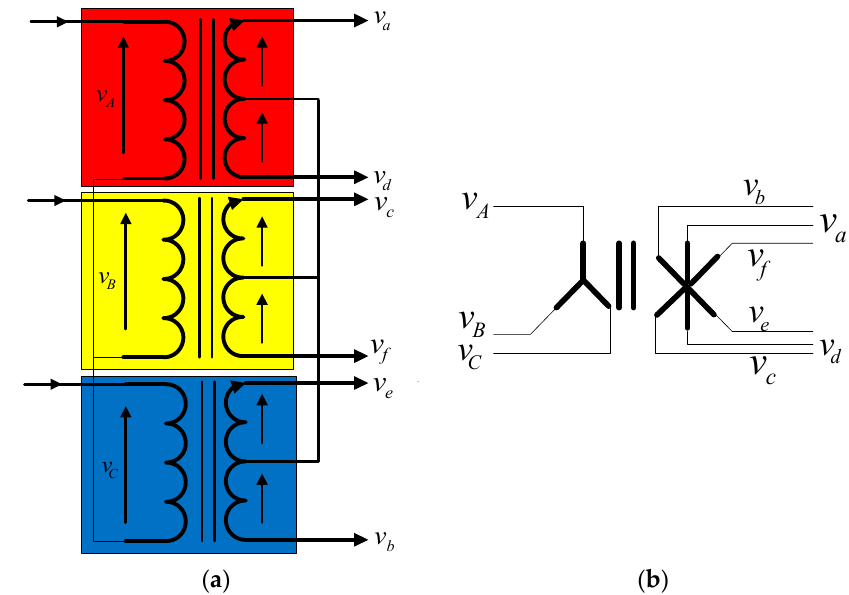
Figure 4. Symmetrical six-phase output with primary star; ( a ) connection diagram; ( b ) symbolic